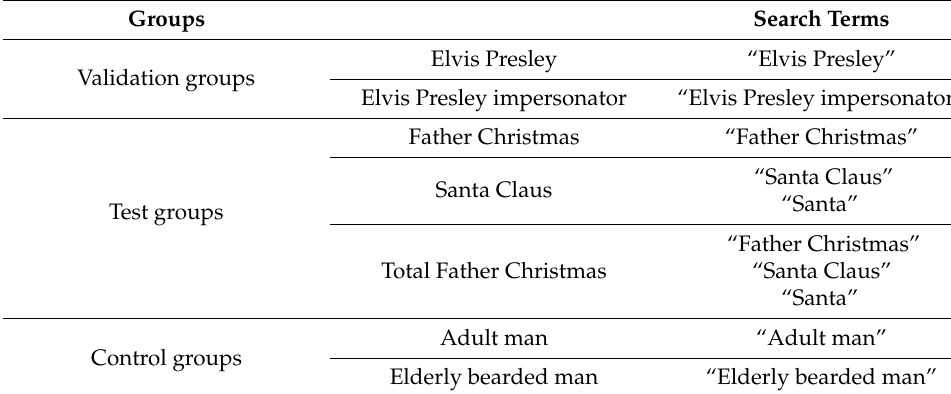
Table 2. Study group populations and corresponding google image search terms. Groups